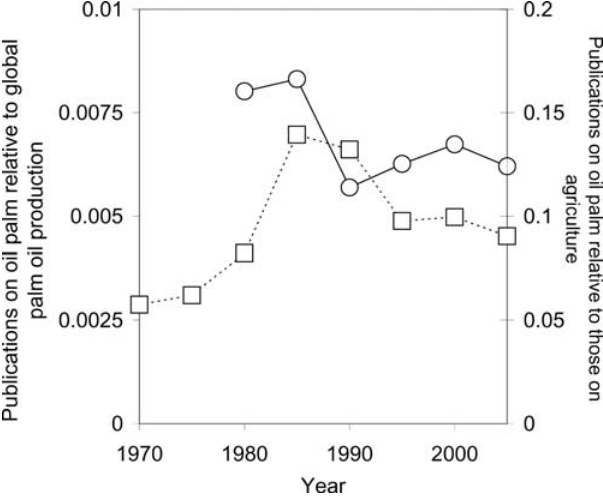
Figure 2. Relative number of publications on oil palm between 1970 and 2005. Round symbols show publications relative to palm oil production worldwide between 1980 and 2005 [2]. Square symbols show publications relative to those on agriculture between 1970 and 2005 [7].